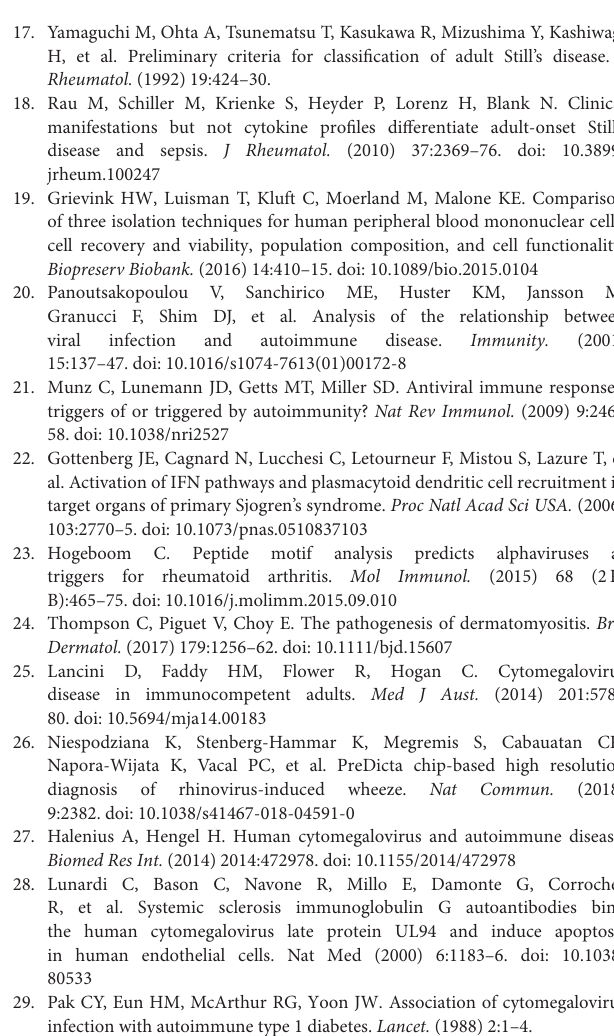
Supplementary Figure 1 | Comparison of the anti-CMV IgM antibody levels in AOSD patients with different clinical manifestations. The levels of anti-CMV IgM antibody in AOSD patients with or without pneumonia (A) , pleuritis (B) , pericarditis (C) , hepatomegaly (D) , splenomegaly (E) , lymphadenopathy (F) , and myalgia (G) . The data represent the mean ± SD by Student’s t -test. Supplementary Figure 2 | Comparison of the anti-CMV IgG antibody levels in AOSD patients with different clinical manifestations. The levels of anti-CMV IgG antibody in AOSD patients with or without pneumonia (A) , pleuritis (B) , pericarditis (C) , hepatomegaly (D) , splenomegaly (E) , lymphadenopathy (F) , and myalgia (G) . The data represent the mean ± SD by Student’s t